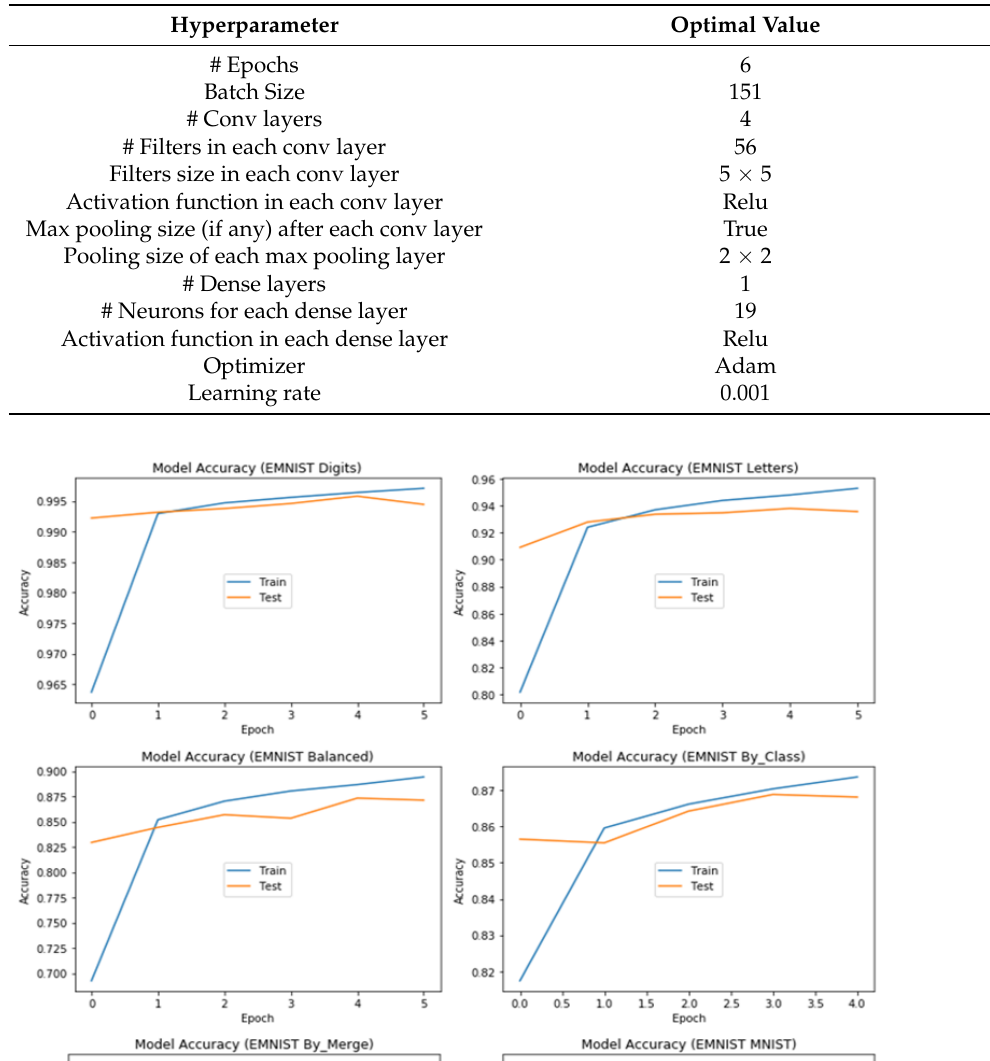
Table 3. Optimal hyperparameters of the CNN architecture discovered by the proposed CSA method.